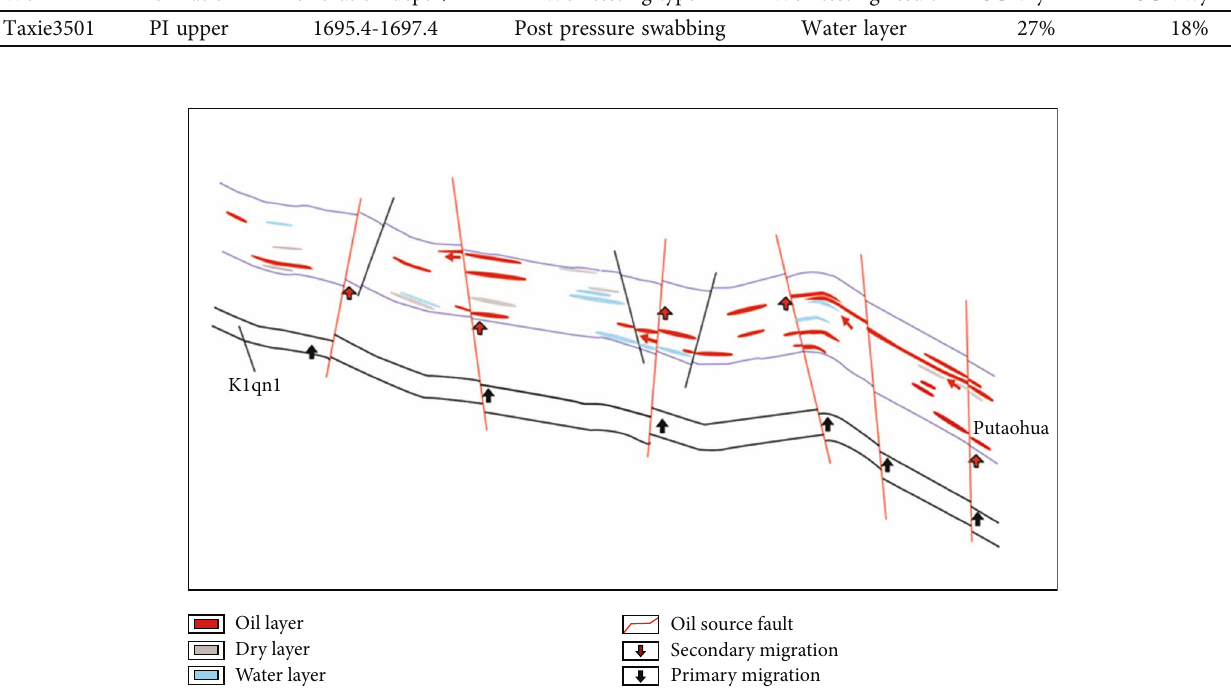
Table 13: Statistical table of production test results and SGR value of reservoir control fault section of well Taxie 3501. Well